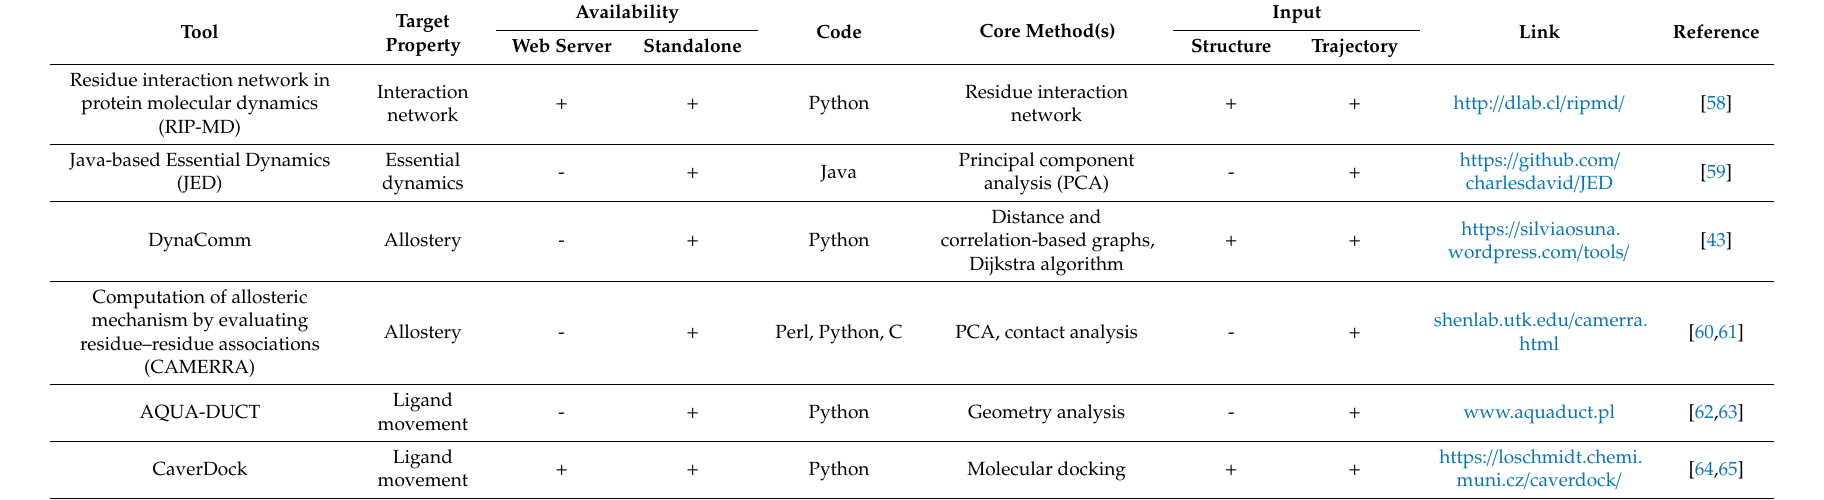
Table 1. Computational tools to extract valuable information for protein engineering from molecular dynamics (MD)